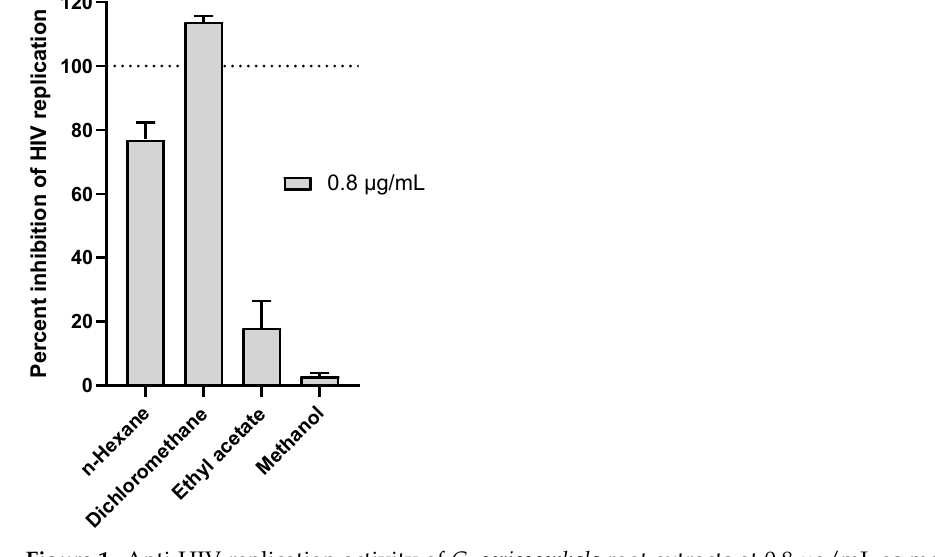
Figure 1. Anti-HIV replication activity of G. sericocephala root extracts at 0.8 µg/mL as measured using the in vitro deCIPhR assay. Briefly, the HeLa-SXR5 cell line was infected with the CXCR4-tropic HIV isolate NL4-3 [24], and infection was monitored in SXR5 cells due to β -galactosidase expression of an HIV long terminal repeat (LTR)-driven LacZ gene. Reduced or eliminated β -galactosidase activity in infected cells in the presence of test agent thus indicated inhibition of HIV replication.